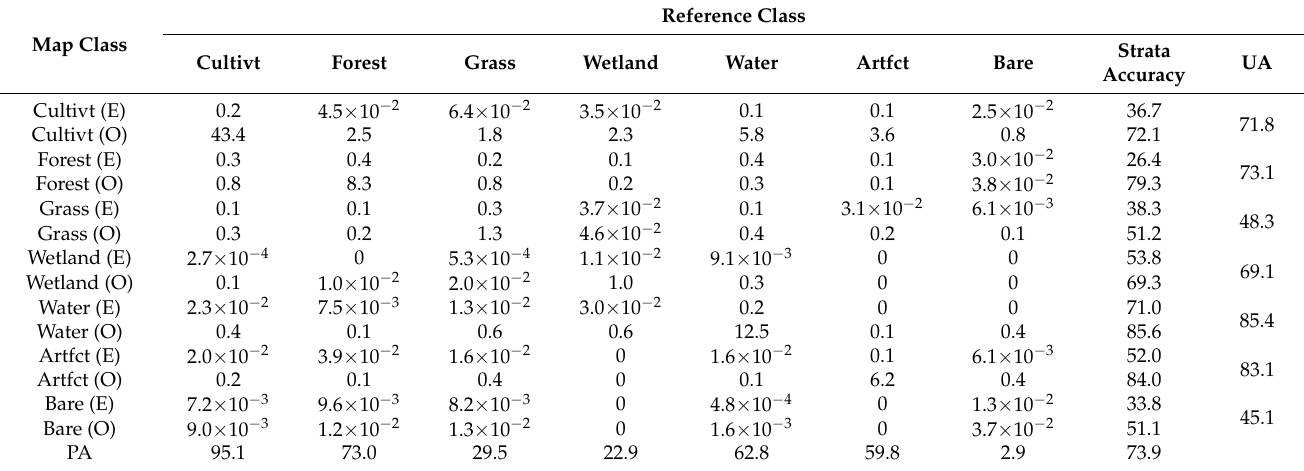
Table A1. Error matrix and accuracy assessment for the original map based on the full model-training sample set (cell proportions and accuracy measures in